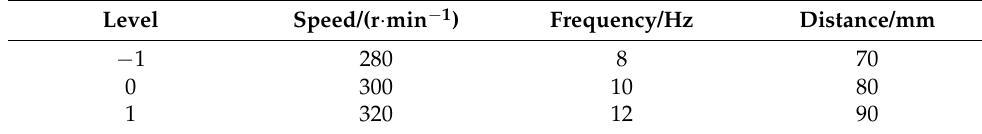
Table 1. Coding table of experiment factors and levels.